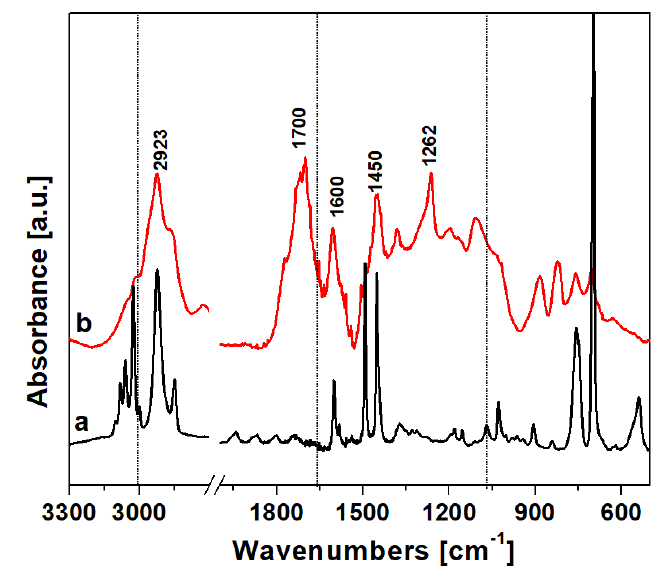
Figure 2. Vibrational spectra in the region 3300–500 cm − 1 of (a) the hyper-crosslinked polymer polymer and (b) polystyrene precursor.